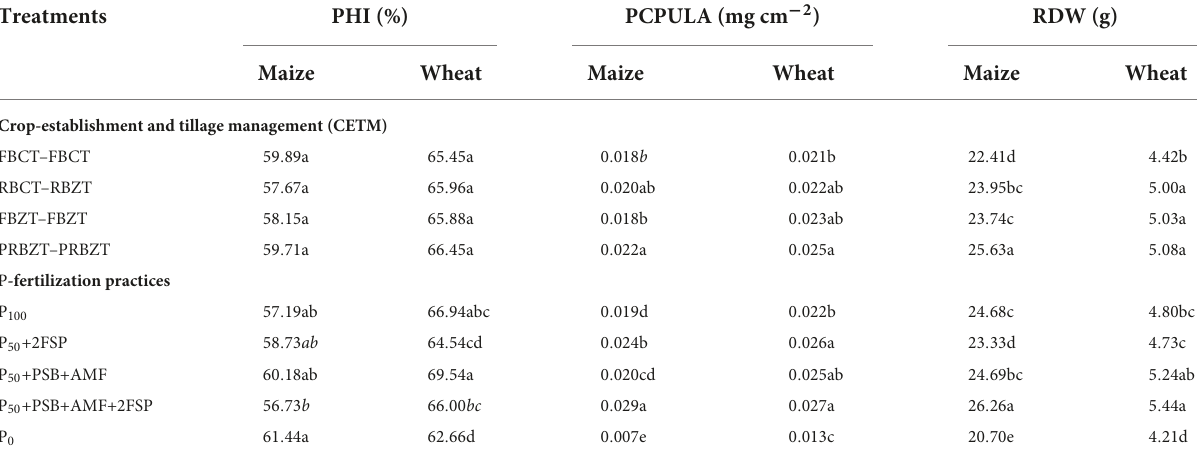
TABLE 4 Influence of crop-establishment and tillage management (CETM) and P-fertilization practices on P-harvest index (PHI), P content per unit leaf area (PCPULA), and root dry weight (RDW) of maize and wheat crops under MWCS (2-years’ av.). Treatments PHI (%) PCPULA (mg cm − 2 ) RDW (g) Maize Wheat Maize Wheat Maize